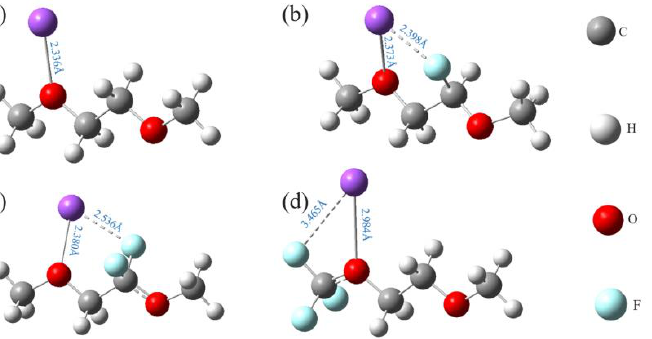
Figure 8. Structures of Na-ion and DME ( a ), fluorinated DME by -CF 1 ( b ), -CF 2 ( c ), -CF 3 ( d ).